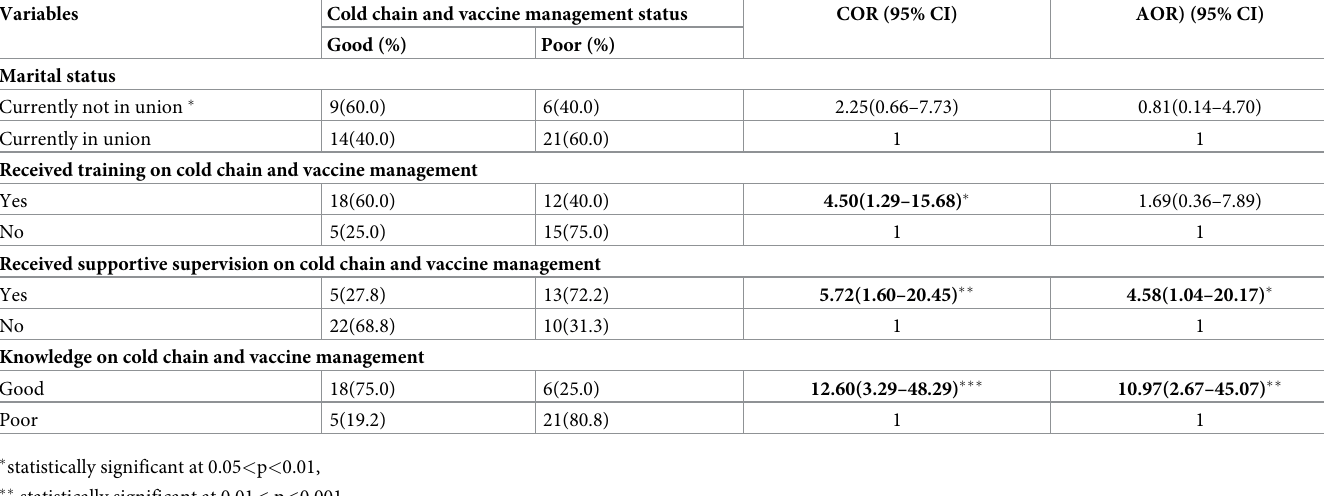
Table 6. Logistic regression analysis of selected variables with cold chain and vaccine management in primary health care facilities of Tigray region, Northern Ethi- opia, 2019(N =